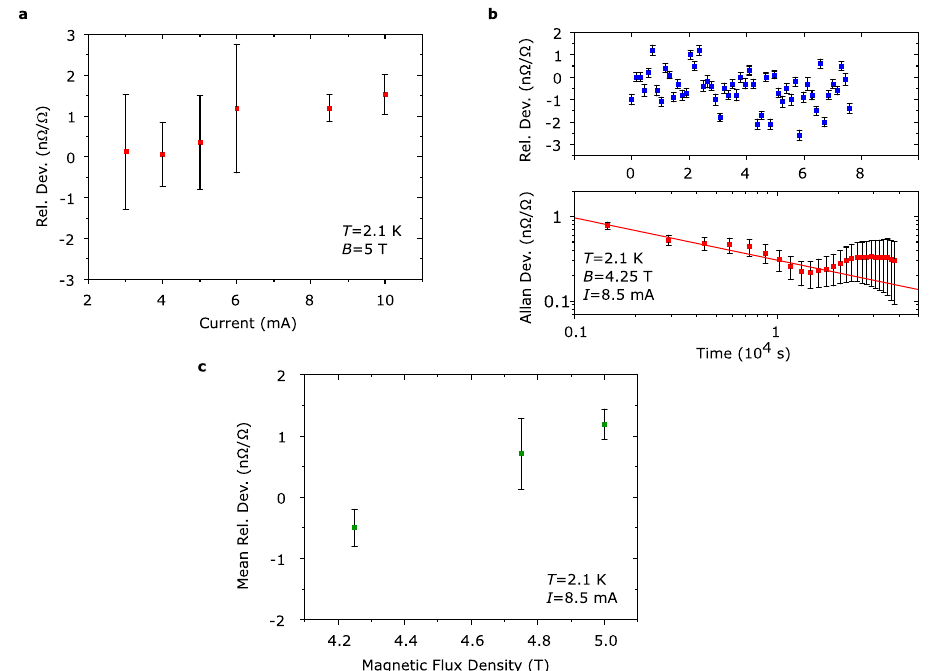
Fig.5|Highbiascurrent measurementsonarrays.a Precisioncryogeniccurrent comparator (CCC) measurements using direct comparisons between subarrays showsno signi fi cantdeviationuntil8.5mA.The data consistsofthe mean of 5 – 10 measurements each (20min long) so there is no Allan deviation analysis, and the errorbarsare thereforeonestandarddeviation. b Longerprecisionmeasurements showingtherelativedeviation,whereeachpointisa20minlongCCC-reading,with error bars of one standard deviation. c Corresponding Allan deviation, including